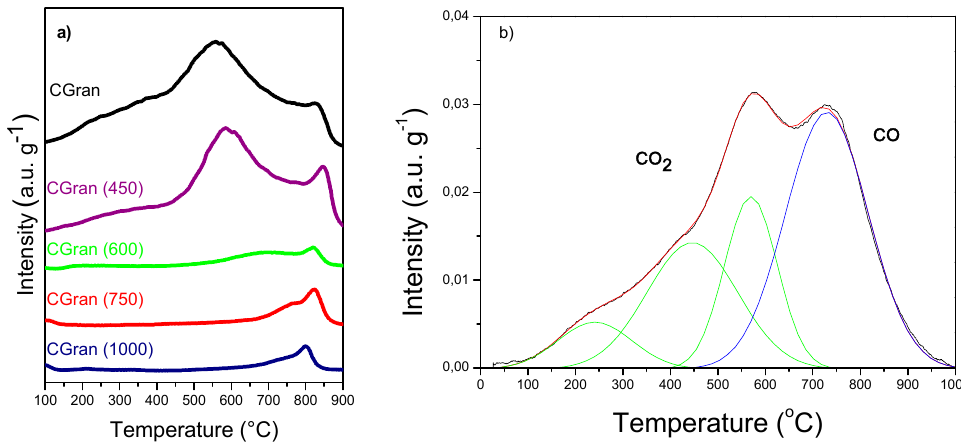
Figure 1. ( a ) Thermal-programmed decomposition (TPD) of CGran and CGran(x) activated carbon supports; ( b ) TPD–MS of un-modified CGran activated carbon.